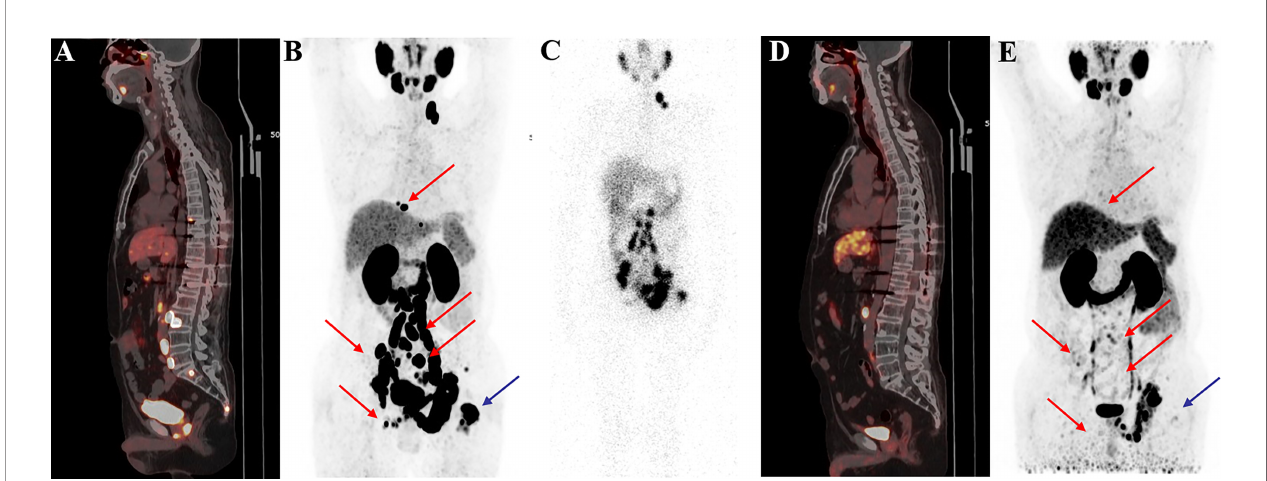
FIGURE 6 | 68 Ga-PSMA-11 PET/CT in a 62-year-old patient with mCRPC. Baseline images (A, B) of multiple bone and lymph node metastases with increased PSMA expression. Post-therapy image (C) showing high 177 Lu-PSMA-I&T aggregation in primary and metastatic lesions. Post-treatment image (D, E) showing multiple osteogenic metastases and reduced PSMA expression compared with before therapy. Metastatic foci in the left clavicle, abdominal aorta, and bilateral iliac paravascular lymph nodes were signi fi cantly reduced and PSMA expression was decreased, suggesting that the treatment was